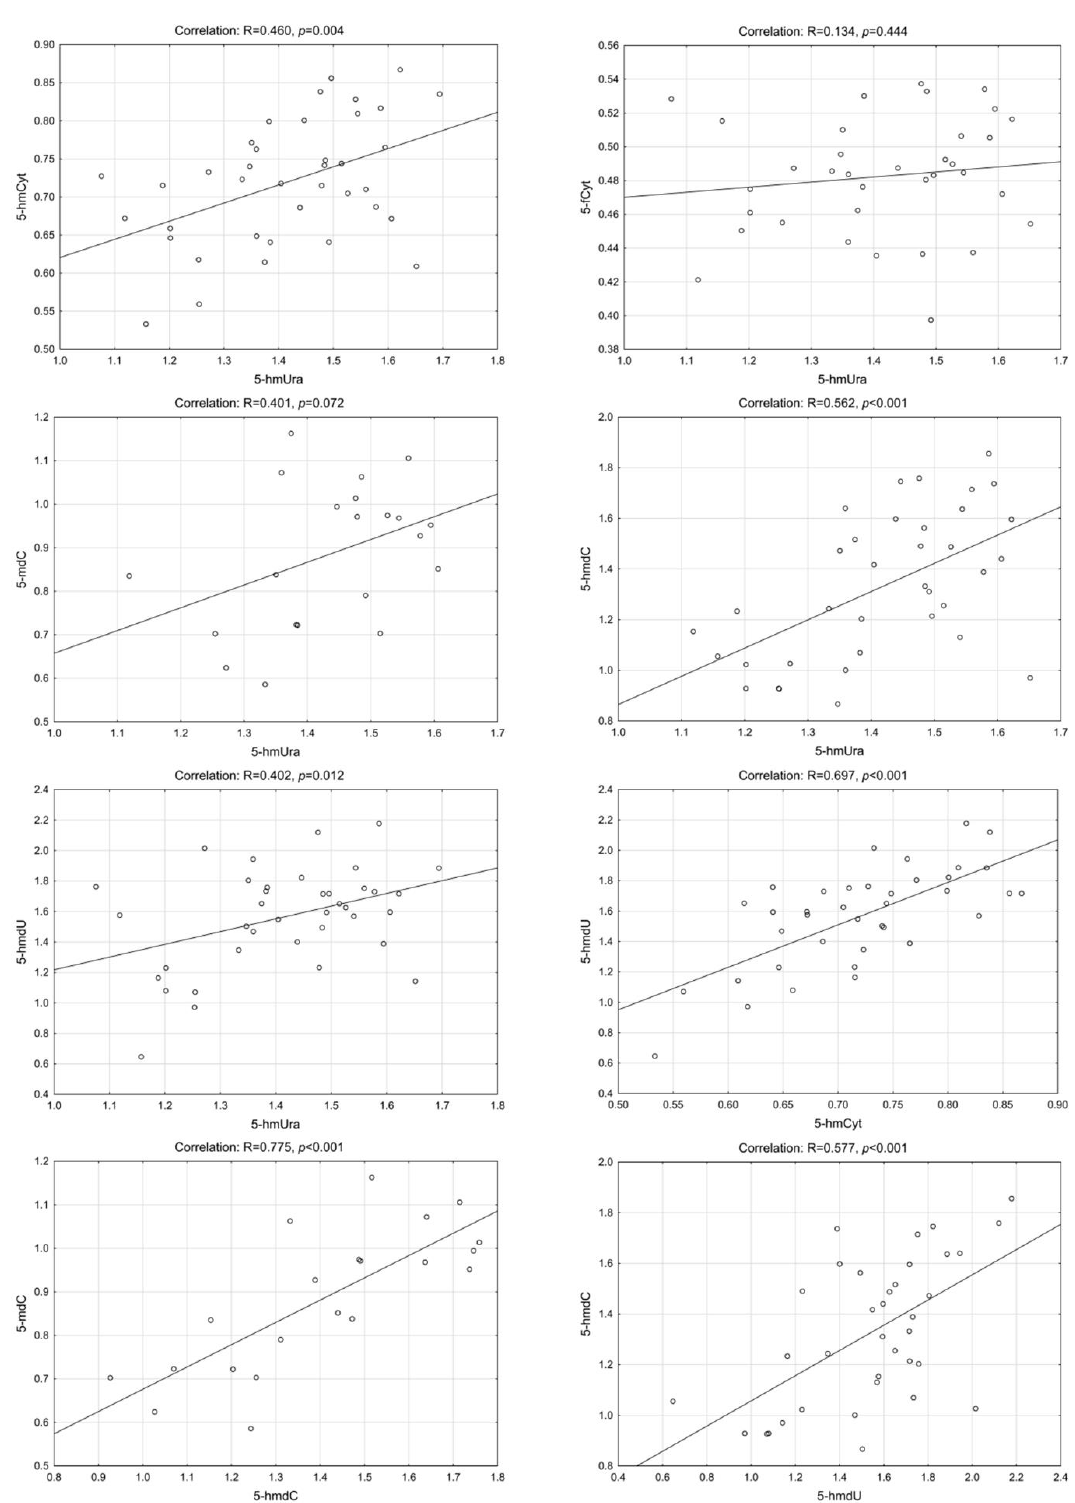
Figure 5. Selected correlations between the levels of DNA epigenetic modifications in urine— patients with inflammatory bowel disease (IDB). 5-hmCyt: 5-hydroxymethylcytosine; 5-hmUra: 5-hydroxymethyluracil; 5-mdC: 5-methyl-2′-deoxycytidine; 5-hmdC: 5-(hydroxymethyl)-2′-deoxycytidine; 5-hmdU: 5-(hydroxymethyl)-2′-deoxyuridine; 5-fCyt: 5-formylcytosine.